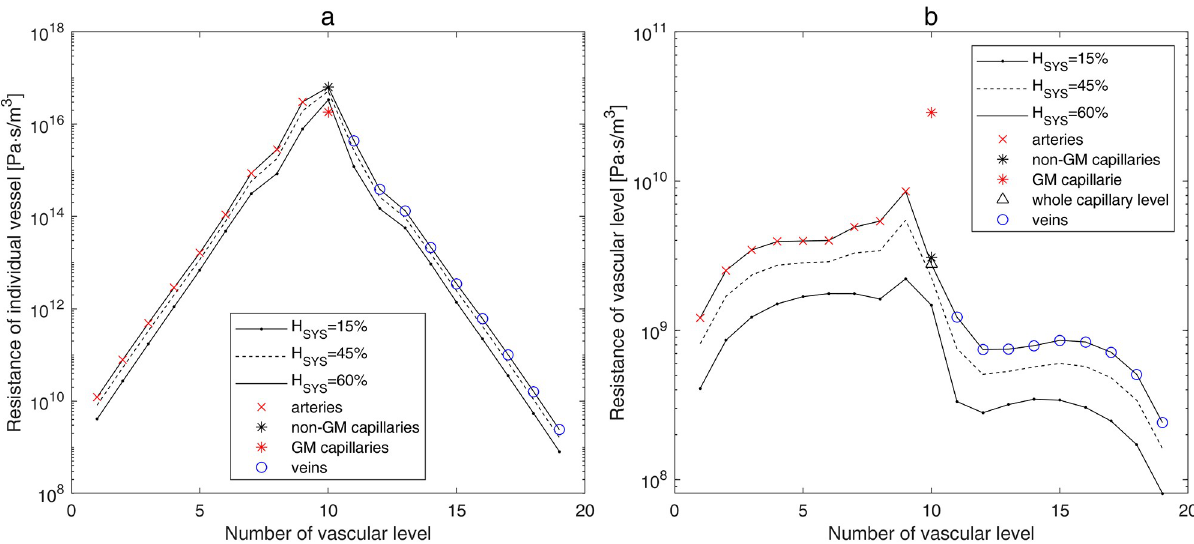
Fig 2. Calculated resistance of the individual vessel (a) and of the whole vascular level (b) for different values of systemic hematocrit.